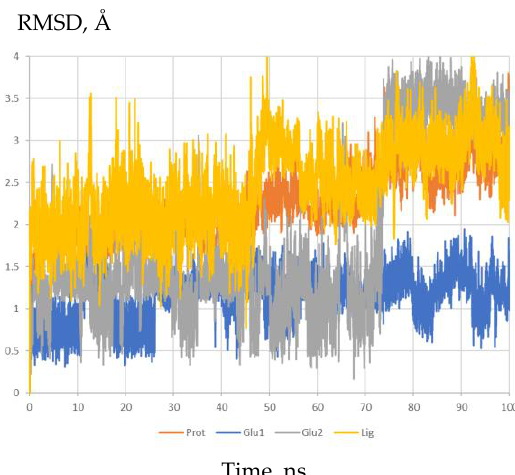
Figure 3. Binding mode of the PAM 6 refined using molecular dynamics simulation. ( A ) General view of the dimeric ligand-binding domain of AMPA receptor (GluA2) and location of the binding site. ( B ) Binding pockets in the protein molecular surface colored by local hydrophobicity (brown for hydrophobic and blue for hydrophilic). ( C ) Detailed view of the binding site. The ligand is represented by a grey ball-and-stick model, the amino acid residues located within 3 Å of it are represented by beige stick models. Hydrogen bonds are shown as cyan lines.